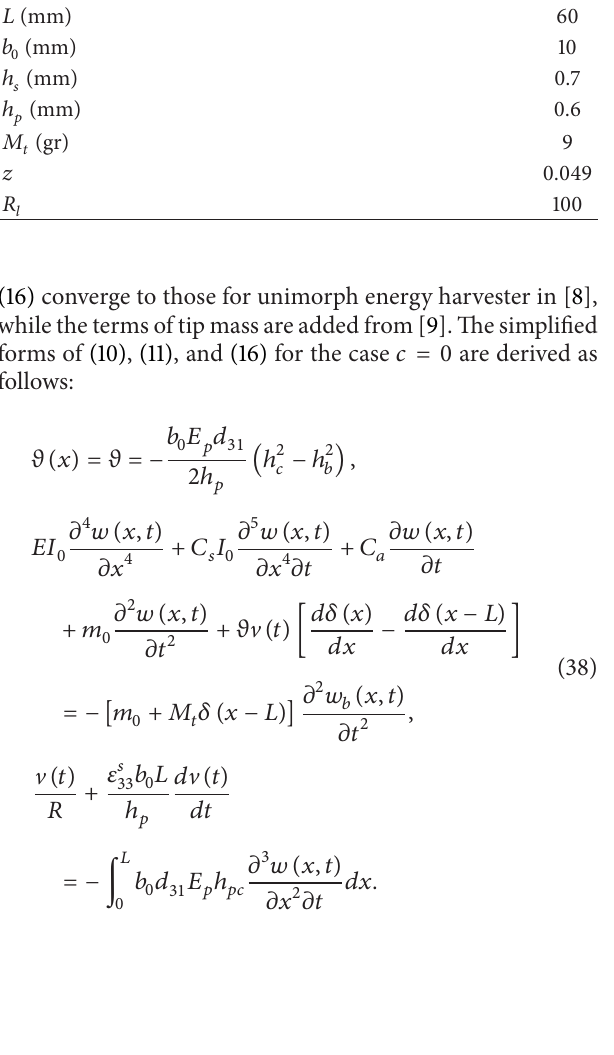
Table 2: Energy harvesters modelling parameters.